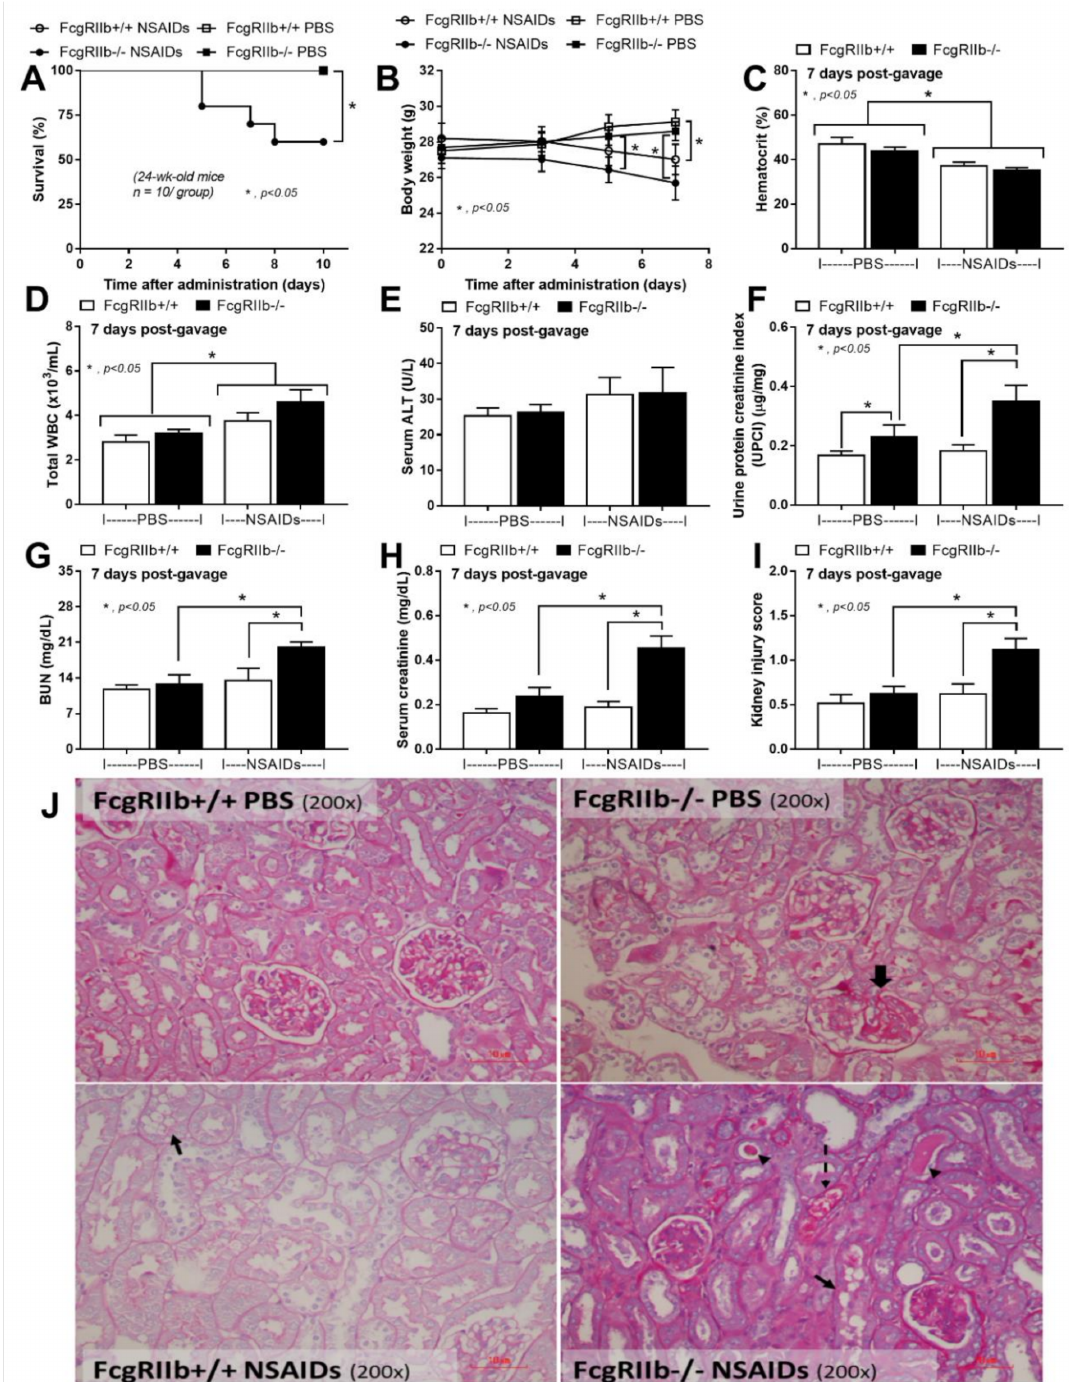
Figure 1. Characteristics of mice after the administration of indomethacin (NSAIDs) or phosphate buffer solution (PBS) control in FcgRIIb-/- lupus mice and wild-type (FcgRIIb+/+) mice as indicated by survival analysis ( A ), body weight alteration ( B ), and the organ injury at 7 days of the administration as indicated by hematocrit ( C ), total white blood cell (WBC) count in blood ( D ), liver injury by serum alanine transaminase ( E ), and renal injury using urine protein creatinine index (UPCI), blood urea nitrogen (BUN), serum creatinine, and renal injury score with the representative Periodic acid- Schiff staining (PAS) histological pictures (original magnification 200 × ) ( F – J ) are demonstrated ( n = 7–10/time point or group). Thick arrow, prominent mesangial staining in FcgRIIb-/- PBS; thin arrows, NSAIDs-induced tubular vacuolization in both mouse strains; arrow heads, proteinaceous cast formation in renal tubule of NSAIDs administered FcgRIIb-/- mice; dotted-line arrow, red blood cell casts in renal tubule of NSAIDs administered FcgRIIb-/-